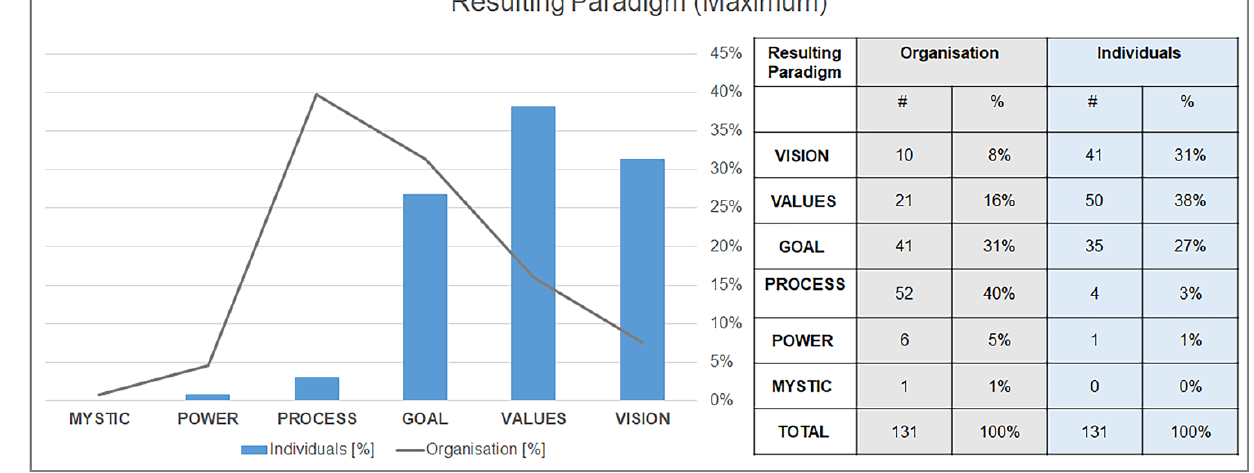
Fig. 1. Left: Summary of the number of participants with selected paradigm. Right: Absolute and relative number of participants with the respective selected